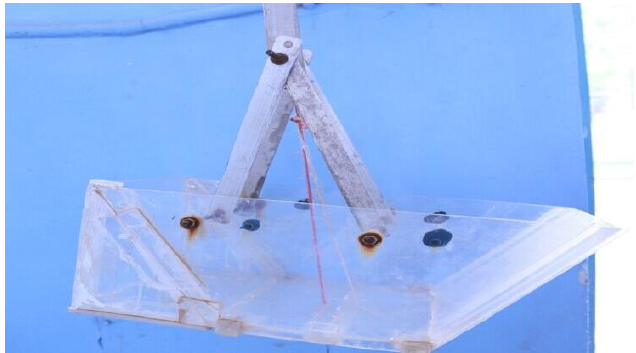
Figure 6. Sand container. It is used to collect the bed load sediments and weigh them with the help of the electric balance above. Considering the stability and the maximum capacity, the section mor- phology of the bed load container was designed as an irregularly shaped